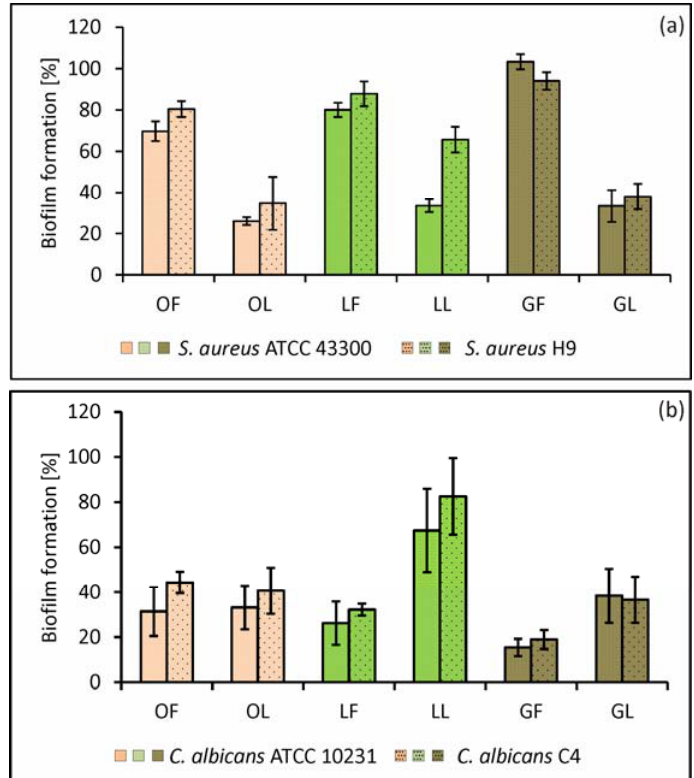
Figure 1. Biofilm formation of Staphylococcus aureus ATCC 43300 and clinical S. aureus H9 ( a ); Candida albicans ATCC 10231 and clinical C. albicans A4 ( b ); on the abiotic (polystyrene) surface in the presence of subMICs of fractionated SBT extracts. LF, GF, OF denote phenolic fractions of leaf, twig, and fruit-derived extracts, respectively; LL, GL, OL denote nonpolar (lipid) fractions of leaf, twig, and fruit-derived extracts, respectively. Inhibitory effect was analyzed in terms of metabolic activity of biofilm mass by LIVE/DEAD BacLight Bacterial Viability kit ( S. aureus ) and the “fluorescein diacetate (FDA) reduction” method ( C. albicans ). The percentage ± S.D. of biomass activity compared with the control (untreated), which was considered as 100%, is presented.